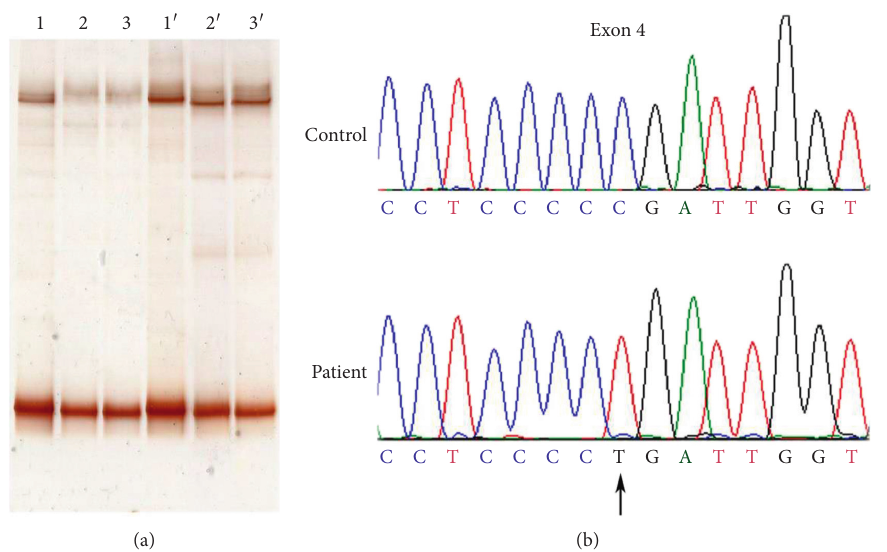
Figure 3: HA, SSCP, and DNA sequence analysis of exon 4 of the ALB gene of the patient reported herein. (a) Heteroduplex analysis (HA) and single-strand conformational polymorphism (SSCP) analysis. The DNA sequences encompassing exon 4 and the exon–intron junctions from the patient and two controls were amplified using primers A07A and A08A, and the fragments were electrophoresed on a non- denaturing polyacrylamide gel: lane 1, proband; lanes 2 and 3, and controls. The same samples were denatured and cooled before loading: lane 1 ′ , proband, lanes 2 ′ and 3 ′ , and controls. (b) DNA sequence of the mutated region of exon 4 in the patient. The arrow indicates the homozygous C-to - transition at position c.412 (c.412C >